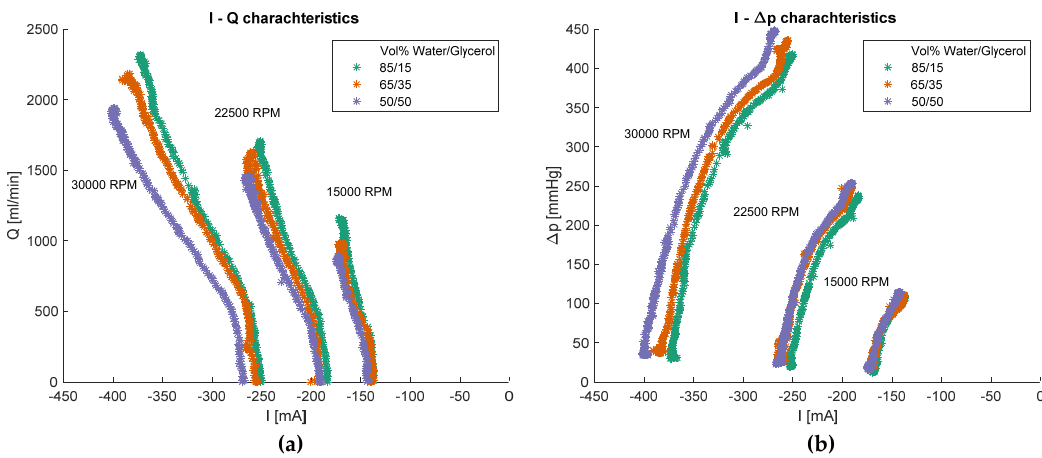
Figure 4. ( a ) The I–Q characteristics of the system; ( b ) The I– (cid:52) p characteristics of the system. The three Figure 4. (a) The I–Q characteristics of the system; (b) The I–△p characteristics of the system. clusters of curves in both plots correspond to di ff erent motor speeds while the color coding refers to The three clusters of curves in both plots correspond to different motor speeds while the color di ff erent viscosities of the test liquid. coding refers to different viscosities of the test liquid.